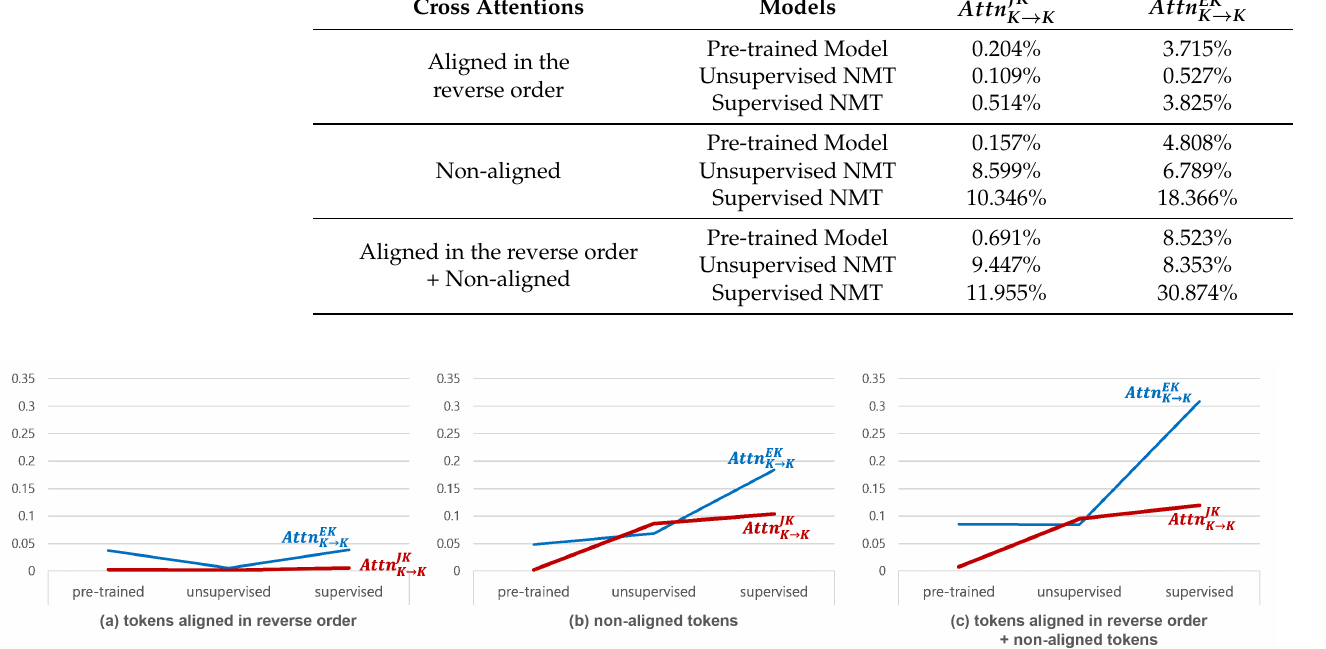
Figure 4. The cross-attentions between the same sentences in Japanese–Korean and English–Korean neural machine translation (NMT) models.